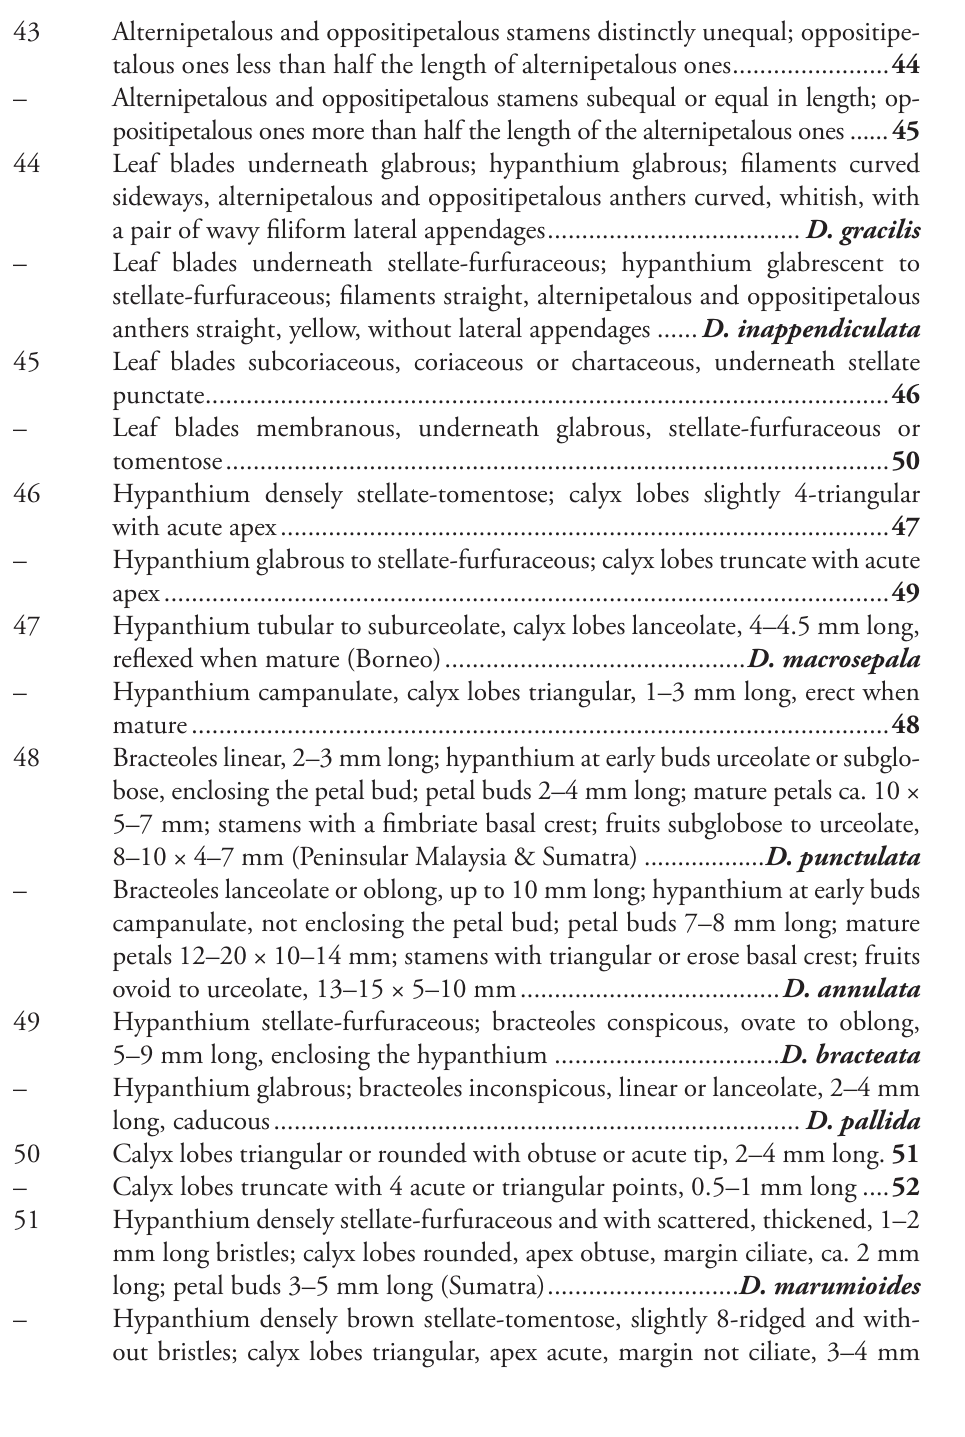
Alternipetalous and oppositipetalous stamens distinctly unequal;